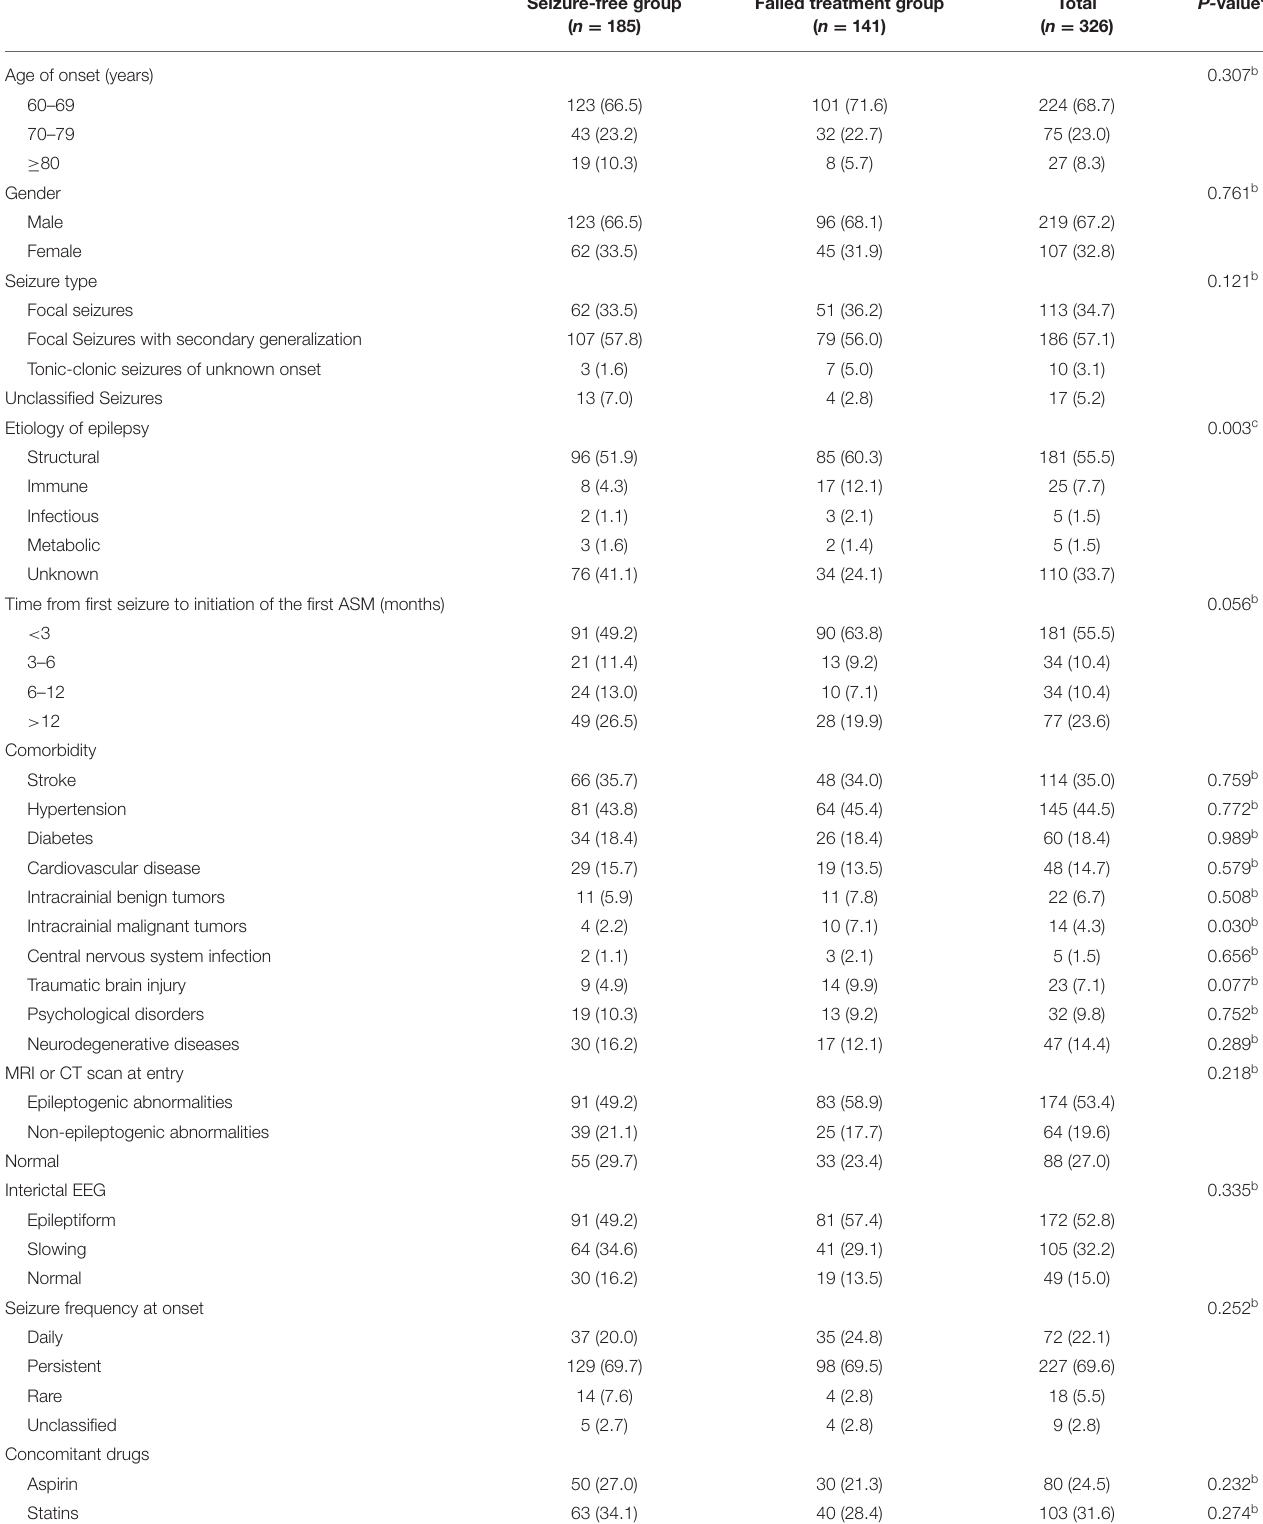
TABLE 1 | Demographic data of elderly patients with new-onset epilepsy, N